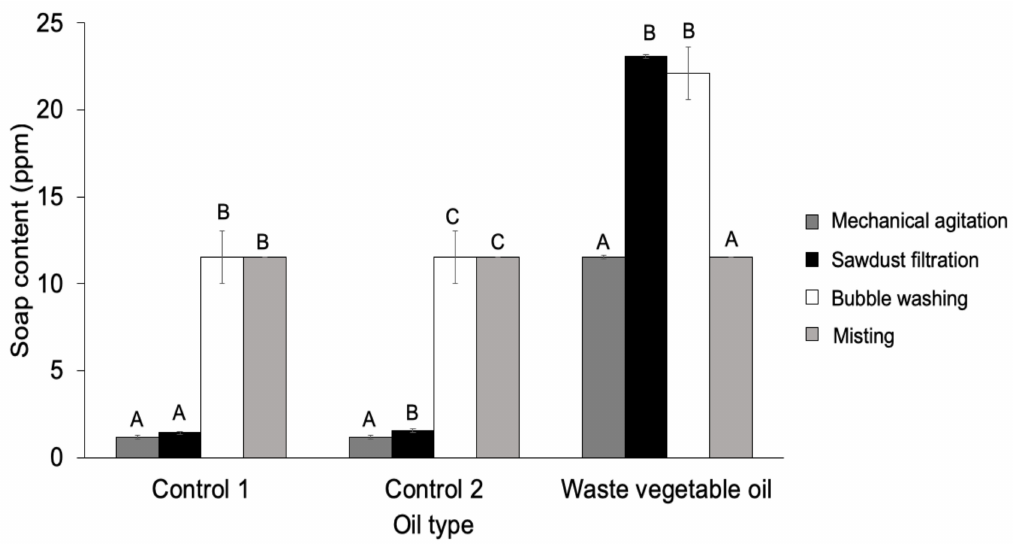
Figure 4. Soap content from biodiesel